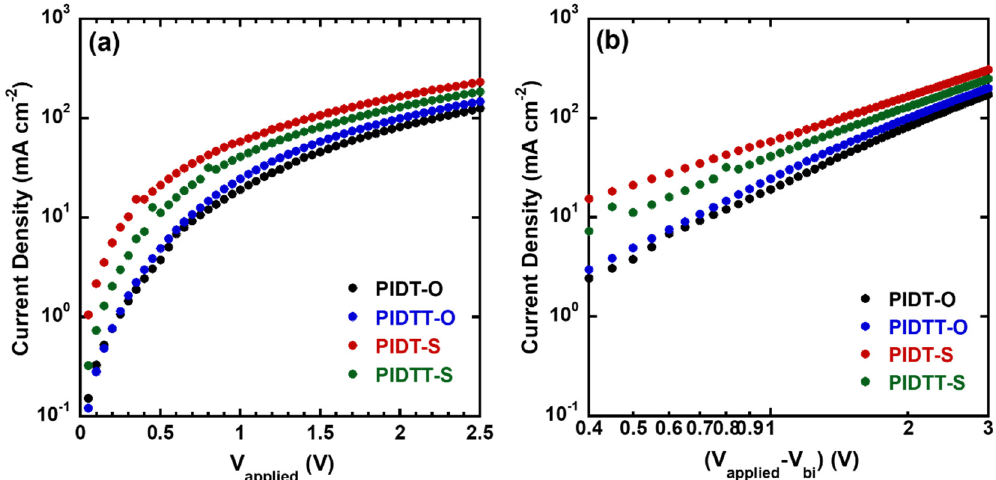
Figure 3. ( a ) The J-V curves of hole-only devices for neat polymers, and ( b ) fitting results to ( a ) from the SCLC model. Table 3. Summary of the hole mobilities of the neat polymers.